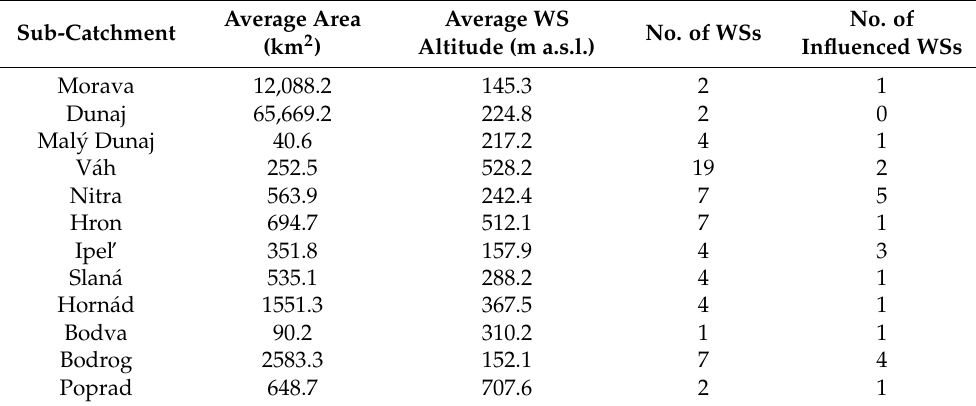
Table 1. Catchment characteristics of the selected water-gauging stations. Average Area Average WS Sub-Catchment (km 2 ) Altitude (m